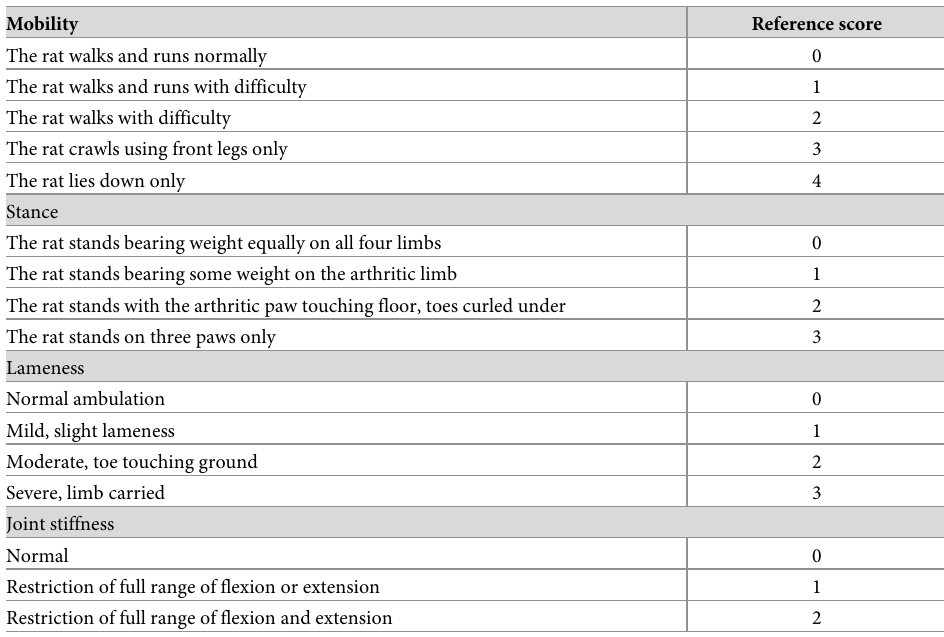
Table 3. Model specific parameters.